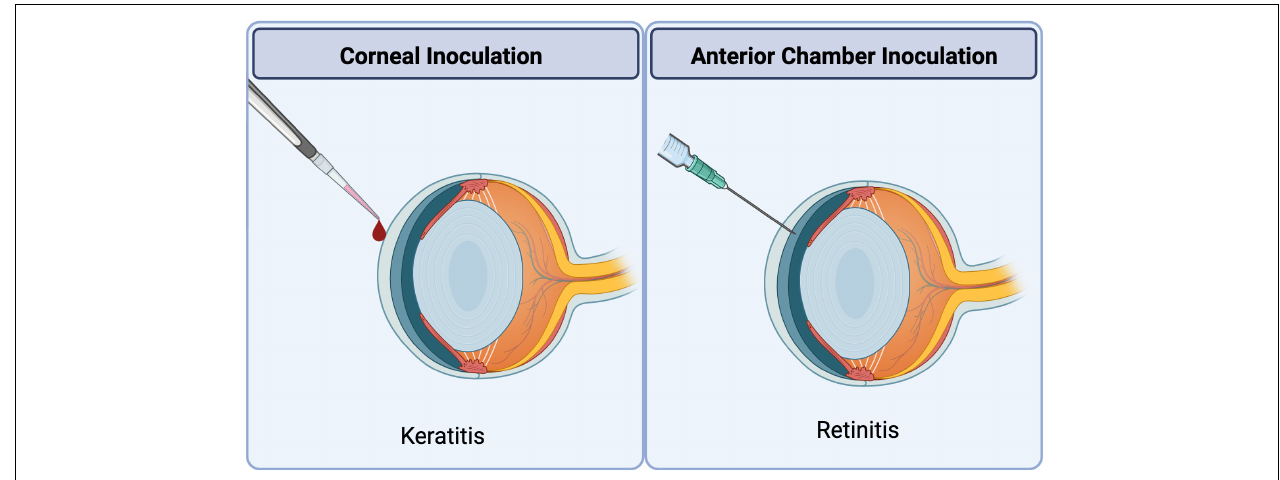
FIGURE 4 | Methods of ocular HSV1 inoculation to induce corneal or retinal disease. Corneal inoculation: Experimental uniocular HSK is induced by topical application of HSV1 onto the corneal surface with or without abrasion depending on the virus strain under investigation. Anterior chamber inoculation: Experimental ARN-like retinal disease is induced in the uninoculated contralateral eye by uniocular injection of HSV1 into the anterior chamber of the ipsilateral